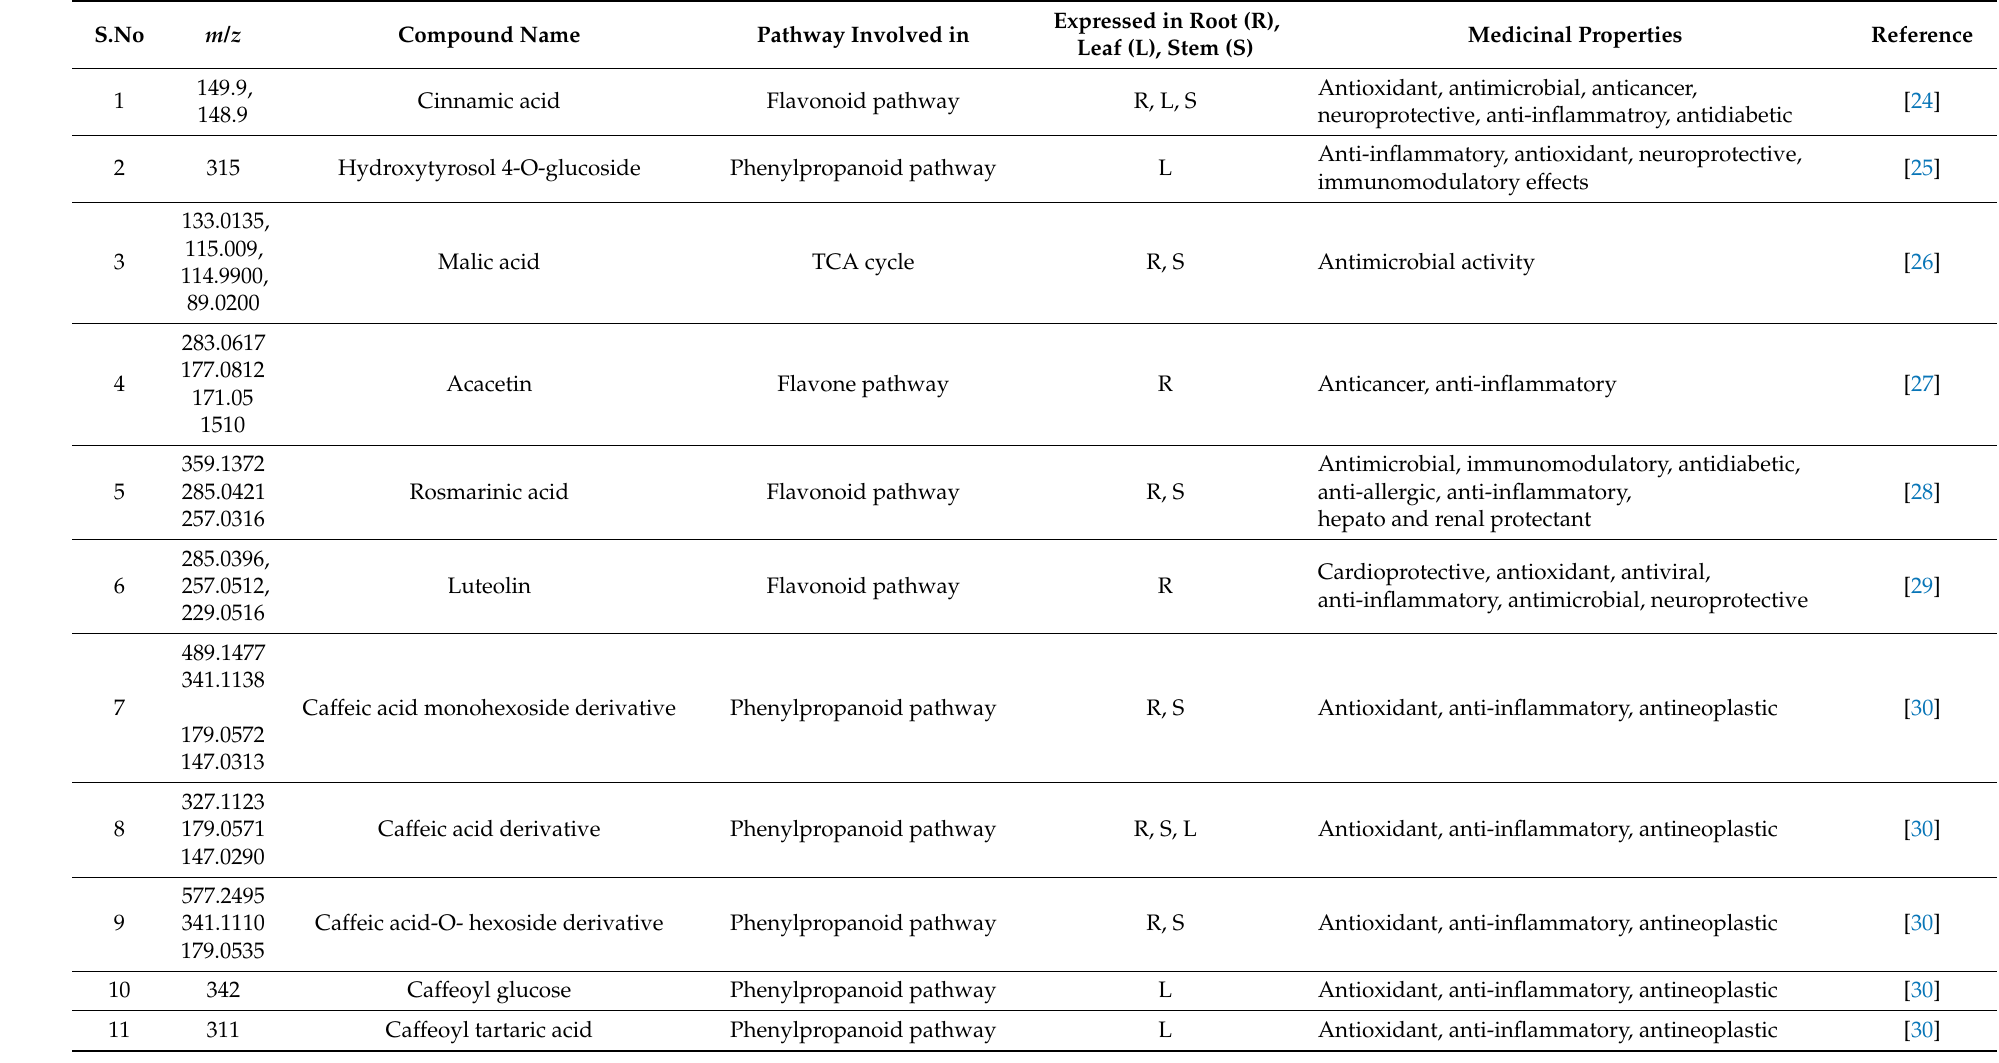
Table 2. Identification of various secondary metabolites from root, stem, and leaves tissue of Sida cordifolia by